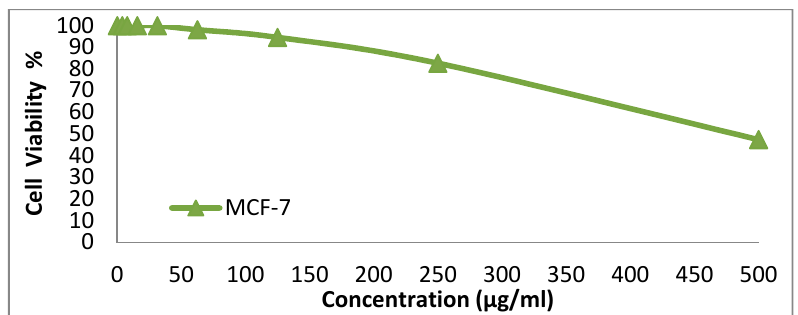
Figure 8. Evaluation of disperse dye 14y on cell line MCF-7.